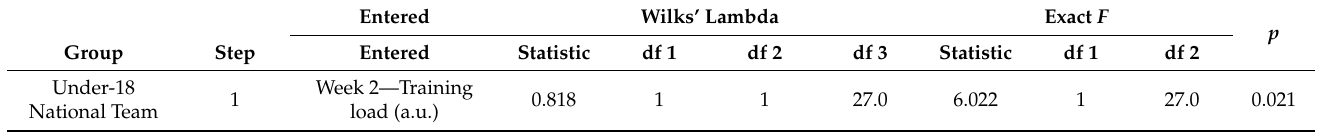
Table 3. Summary of stepwise discriminant analyses by selection group: variables